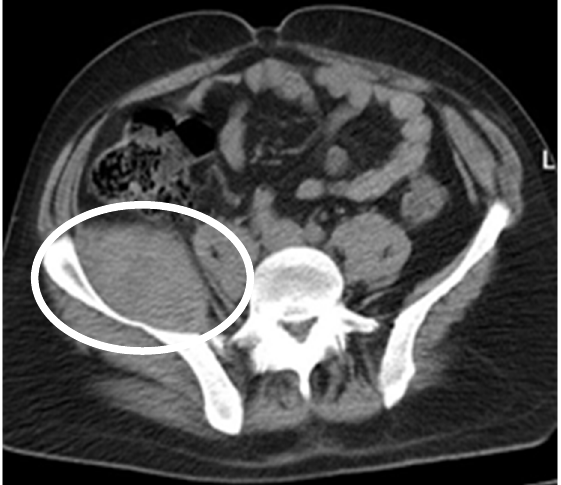
Figure A2. Patient no 4. CT image—Massive right iliopsoas muscle hematoma.